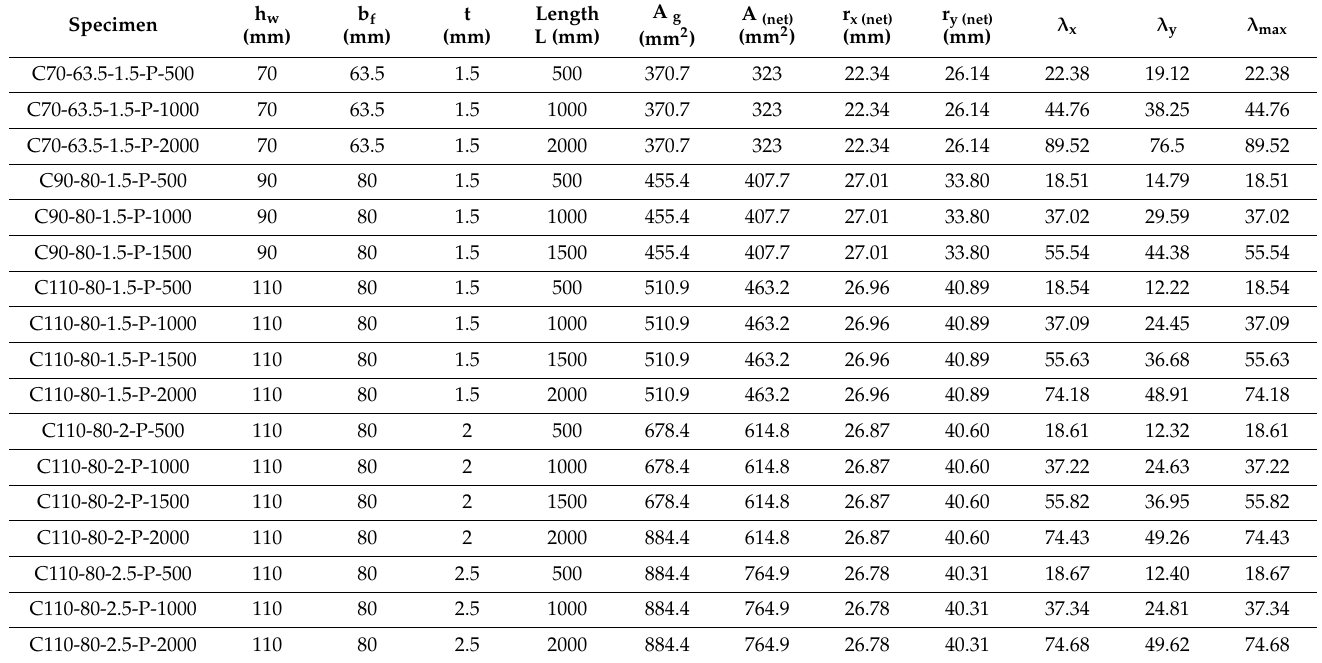
Table 2. Properties of the tested